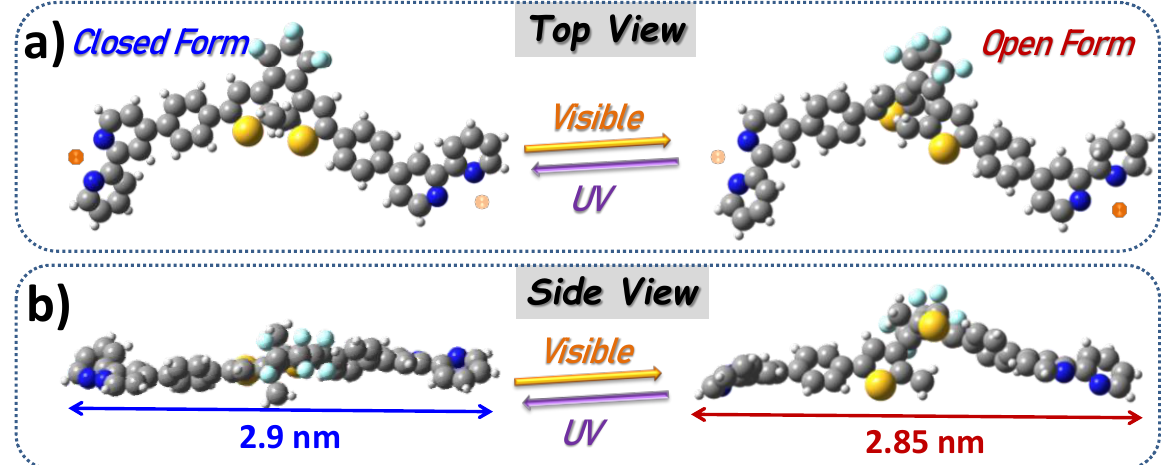
Scheme 1. Top ( a ) and side ( b ) views of bpy-DAE-bpy CF and OF isomers switchable by UV-Visible light irradiation. Molecular lengths are calculated. Gray, blue, yellow and white balls represent C, N, S and H, respectively. Orange balls represent H + ions.